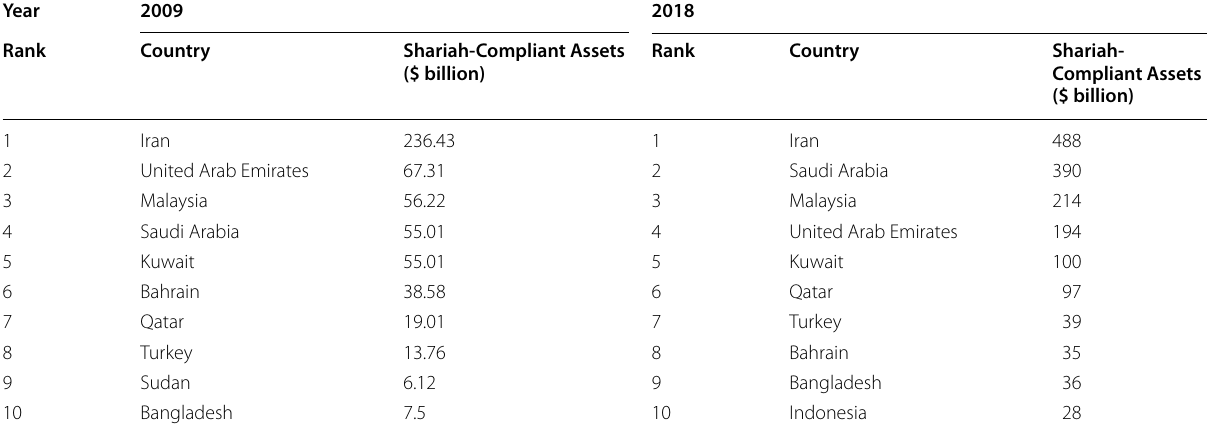
Table 1 Ten leading countries for Shariah-compliant assets. Source : The Asian Banker [59] and IFDI